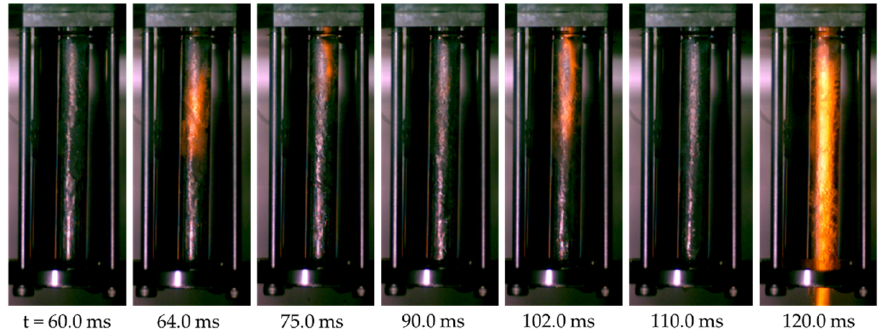
Figure 14. High ‐ speed camera images of unstable ignition. Figure 14. High-speed camera images of unstable ignition.